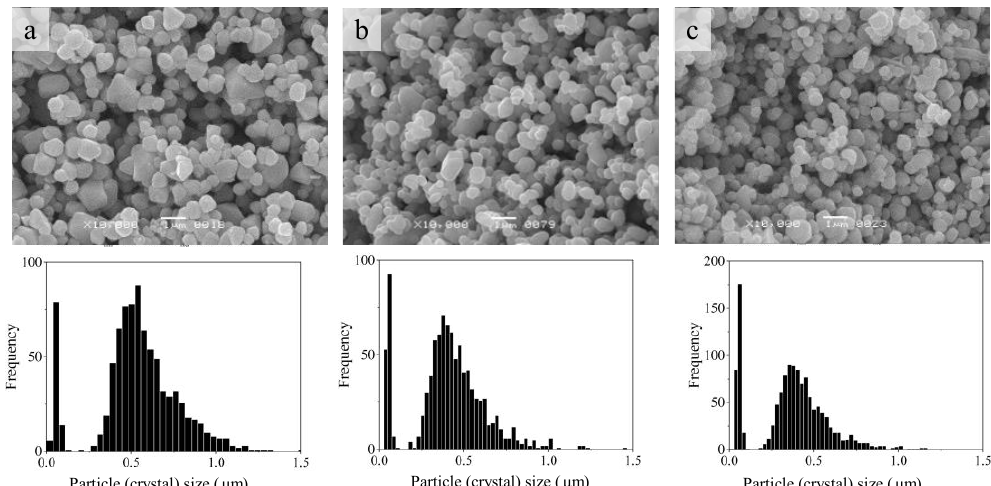
Figure 4. SEM image and crystal size distribution of ZnO powder activated by the TVT method at 213